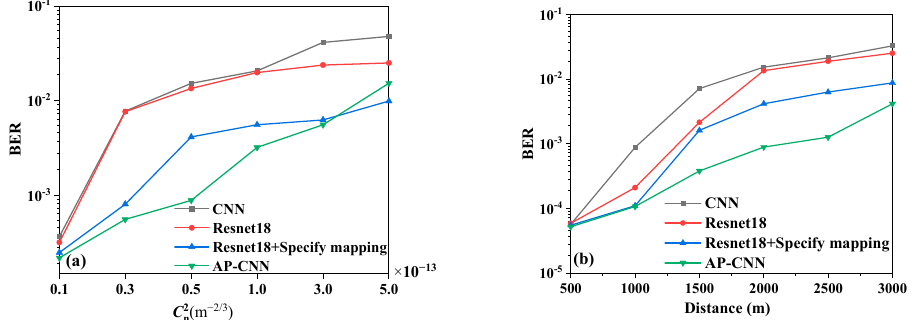
Figure 10. Performance comparison of four OAM demodulators with ( a ) atmospheric refractive index structure constant C 2 n ( b ) transmission distance.